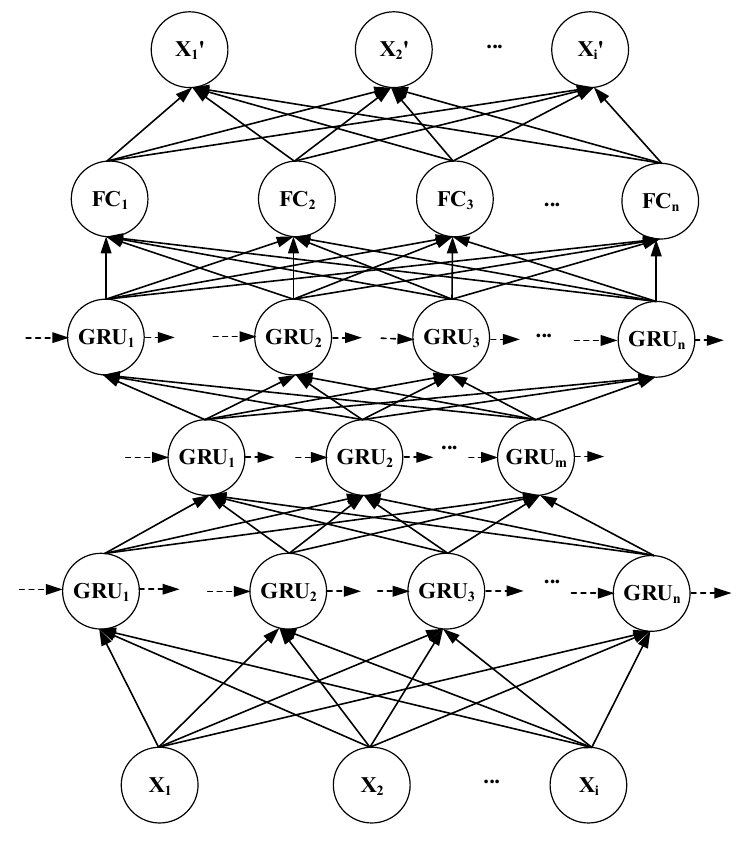
Figure 8. GRU-AE model.